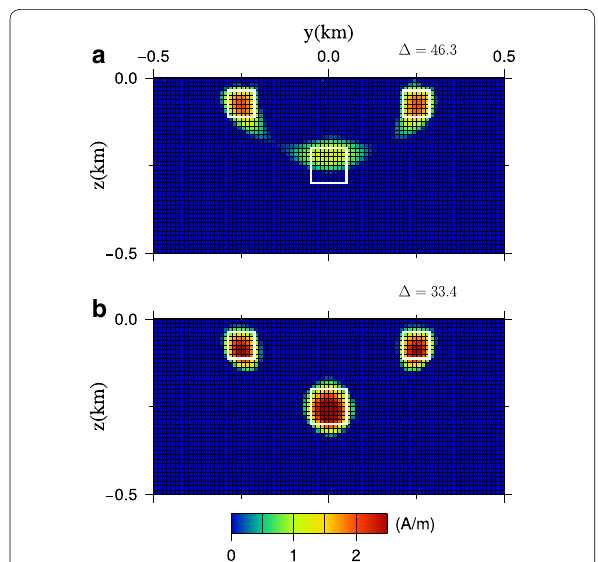
Fig. 12 Cross-section of the models. Cross-section of the models α S 1 0.96 using weighting function w S 1 , and b with a ˆ = using w S 2 . White squares indicate the location of the magnetized blocks of the true model. On the upper right of each panel, the value of (cid:31) is